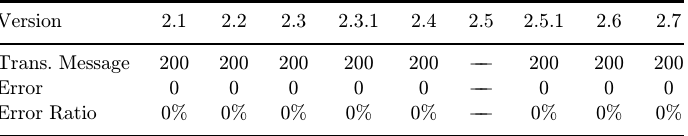
Table 3. Test result of version compatibility of HL7 message.